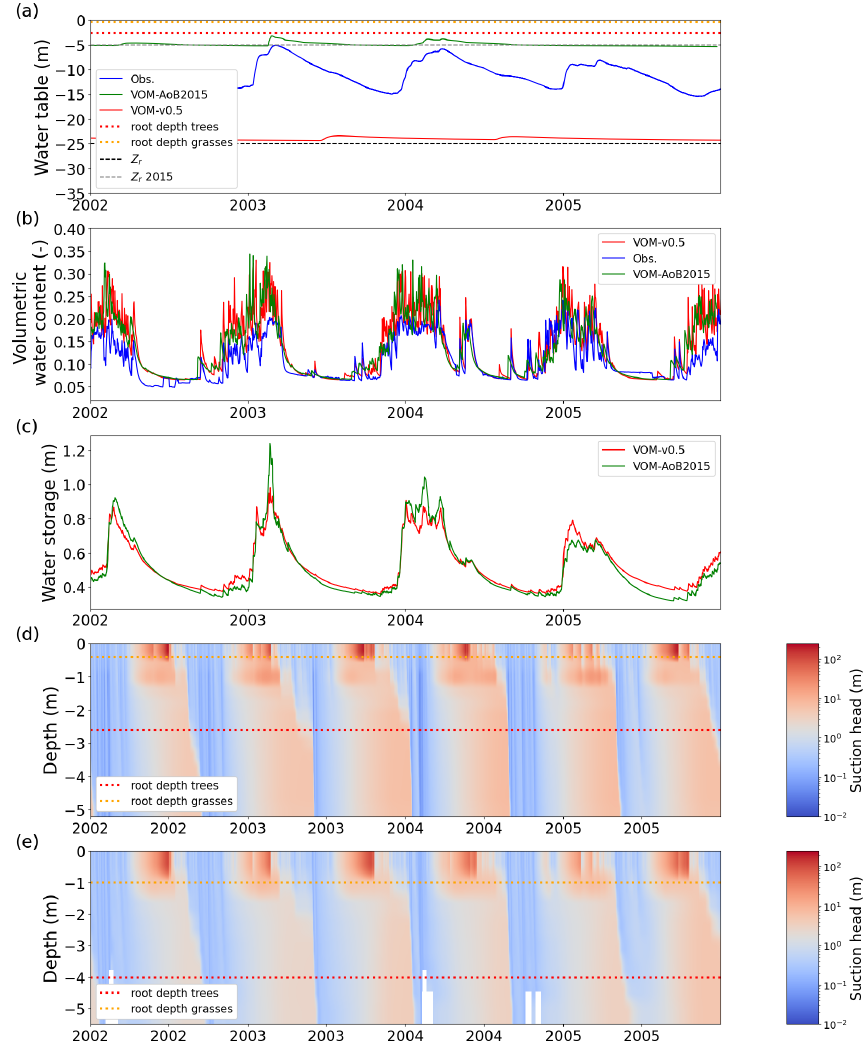
Figure 7. Simulated and observed hydrological state variables at Howard Springs. (a) Groundwater depths, with dashed lines representing the prescribed bedrock depths, dotted lines the rooting depths (trees in red and grasses in orange), the VOM-v0.5 in red, the VOM-AoB2015 in green, and observations of three different boreholes in the vicinity of the study site in blue (Northern Territory Government, Australia, 2018); (b) the volumetric water content in the upper soil layer with the VOM results in red and the results of Schymanski et al. (2015) in green and measurement-based values at 5cm depth at the flux tower sites in blue; (c) the total water storage in the root zone for the VOM-v0.5 (red, storage until 2.6m) and the VOM-AoB2015 in green (storage until 4.0m); (d) the suction heads for the VOM-v0.5; and (e) the suction heads of the VOM-AoB2015. Observed water tables in panel (a) were obtained from the water data portal (Northern Territory